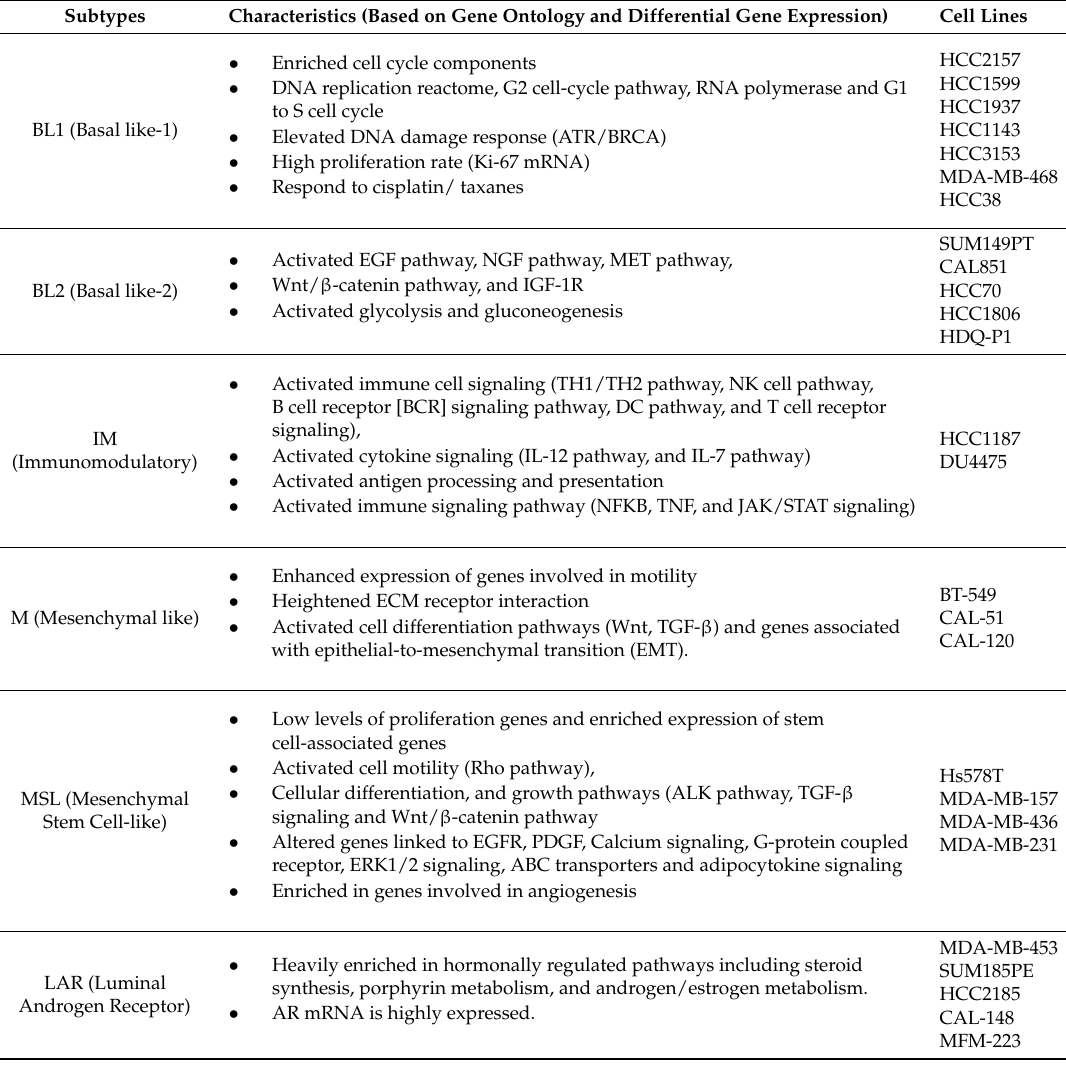
Table 1. Molecular subtyping of triple negative breast cancers (TNBC) based on distinct gene ontology and differential gene expression: TNBC is highly heterogeneous in gene expression. Using cluster analysis, Lehmann classified TNBC into six subtypes. Characteristics of each subtype showing differential gene expression and its representative cell line model for each subtype are provided in the table. Molecular classification helps in the systematic selection of drugs based on biomarkers and enables better prediction of clinical